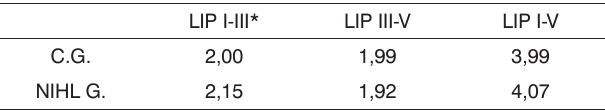
Table 6. Mean values of LIP I-III, LIP III-V and LIP I-V of the right ear in both groups. LIP I-III* LIP III-V LIP I-V C.G.